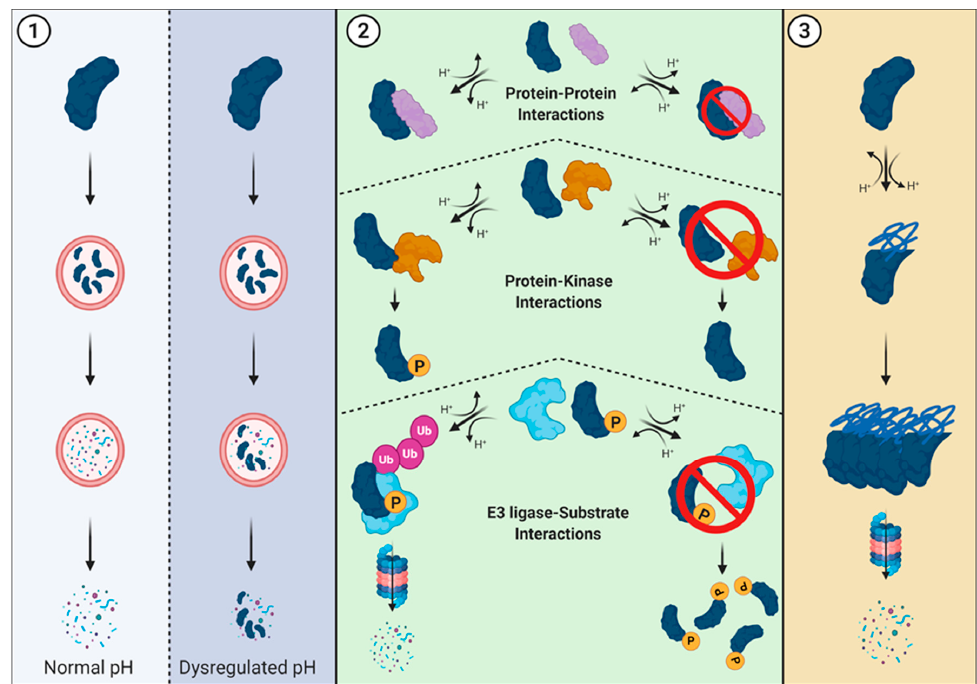
Figure 4. Roles for pH dynamics in regulating proteostasis. ( 1 ) Lysosomal-mediated degradation. Lysosomes have an acidic pH (~4.5–5.0) that allows for optimal protease activity and protein degradation. However, dysregulation of pH within the cytosol (and subsequent lysosomal pH changes) can result in failed or partial degradation. ( 2 ) Overview of protein-protein interactions required for proteasome-mediated degradation. If pH-sensitive residues play critical roles in protein interaction interfaces, dysregulated pH may prevent (or enhance) an interaction from occurring. When the pH-dependent interaction occurs between a kinase and substrate, dysregulated pH may alter phosphorylation, and potential downstream signaling for protein-kinase interactions. Similarly, when the pH-dependent interaction occurs between an E3 ubiquitin ligase and its substrate, dysregulated pH may alter ubiquitination and protein degradation. ( 3 ) Aggregate clearance is the process of removing proteins that have aggregated. Since pH dynamics can also alter the three-dimensional structure of proteins and cause complete misfolding or localized disorder, pH-dependent aggregation is another potential way pH regulates proteostasis.